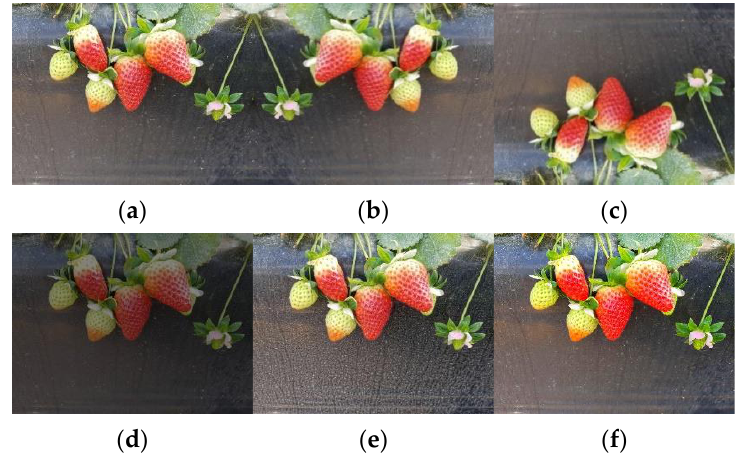
Figure 4. Plot of sample effects produced by different data enhancement methods. ( a ) Original image; ( b ) horizontal mirror; ( c ) vertical mirror; ( d ) diminished brightness; ( e ) contrast enhancement; ( f ) color enhancement.